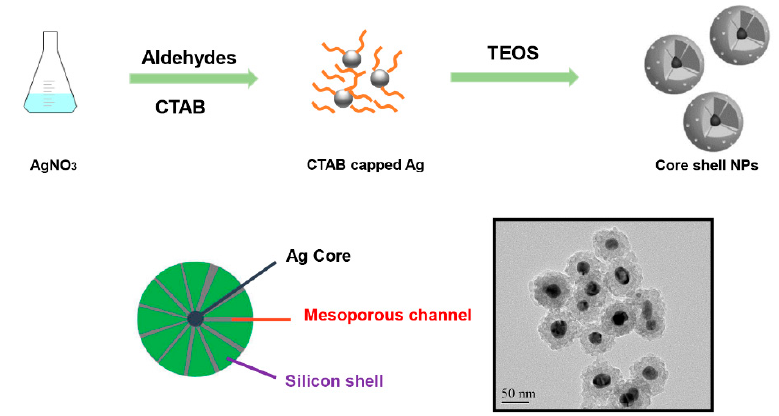
Figure 1. Graphical scheme of the fabrication of Ag@SiO 2 nanoparticles with a single silver core.